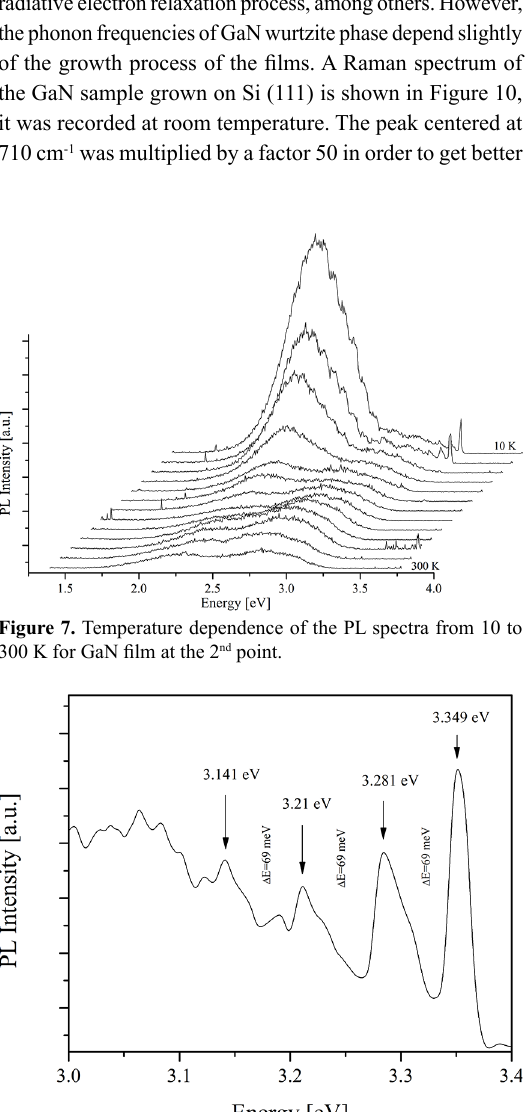
Figure 8. Low temperature (10 K) PL spectrum of GaN film in the UVL band at the 2 nd point.